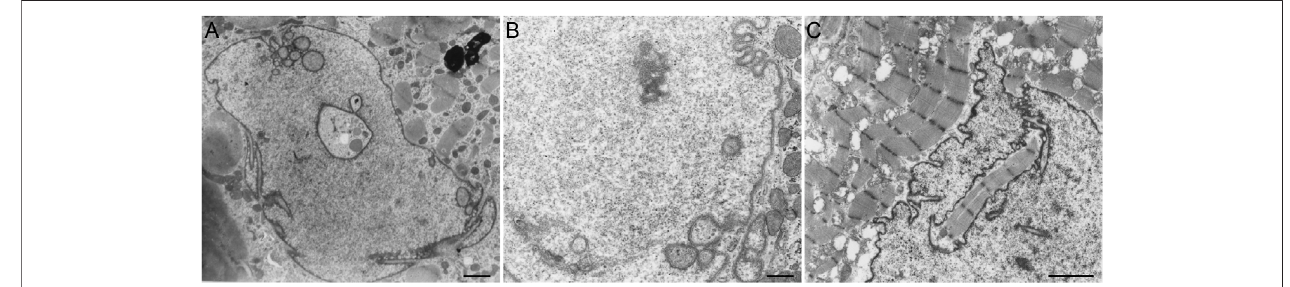
FIGURE 6 | (A) Cardiomyocyte (human ventricular hibernating myocardium; reversible heart failure in vivo ) demonstrating tubular invaginations of the nuclear envelope. Scale bar indicates 5 μ m. (B) Cardiomyocyte nucleus (human ventricular hibernating myocardium; reversible heart failure in vivo ) demonstrating tubular invaginationsofthenuclearenvelope.Scalebarindicates2 μ m. (C) Cardiomyocyte(humanventricularmyocardiumfromdilatedcardiomyopathy)demonstratingalarge invagination of the nuclear envelope, engul fi ng contractile elements. Scale bar indicates 2 μ m. Samples were prepared as described for Figure 4